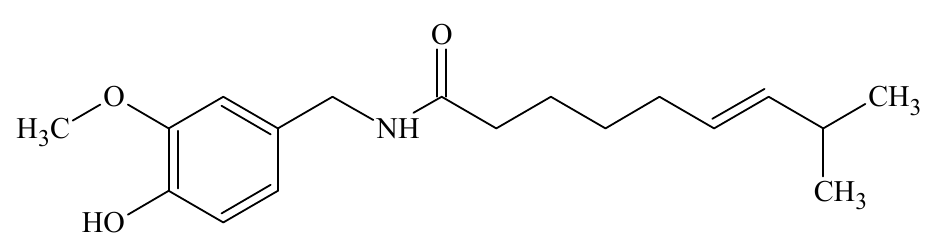
Figure 9. Chemical structure of